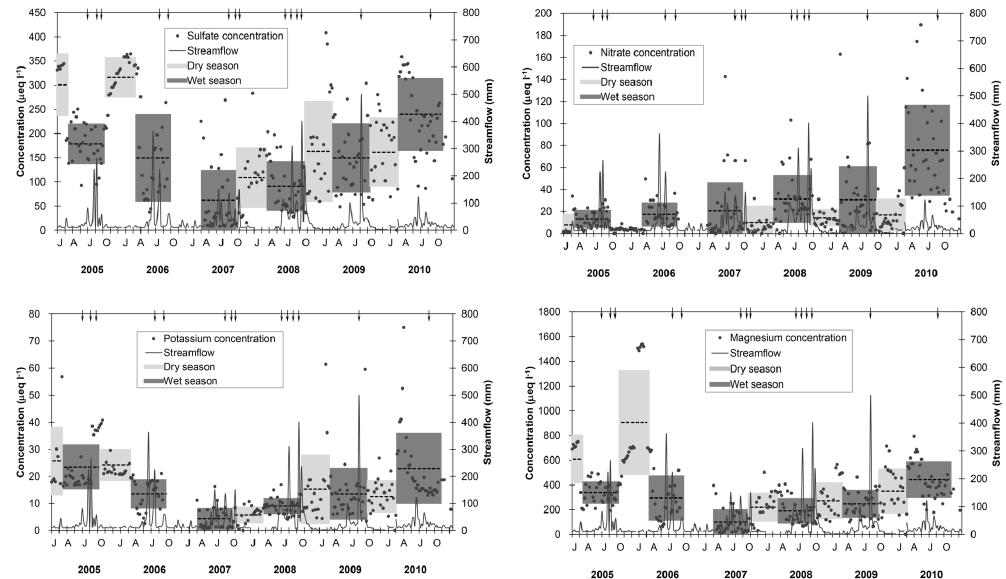
Fig. 3 . Fig. 3. Weekly streamwater chemistry between 2005 and 2010. Each arrow indicates a typhoon. Dash lines and gray rectangles represent the mean and one standard deviation of ion concentration during dry (October–February) and wet (March–September) seasons.